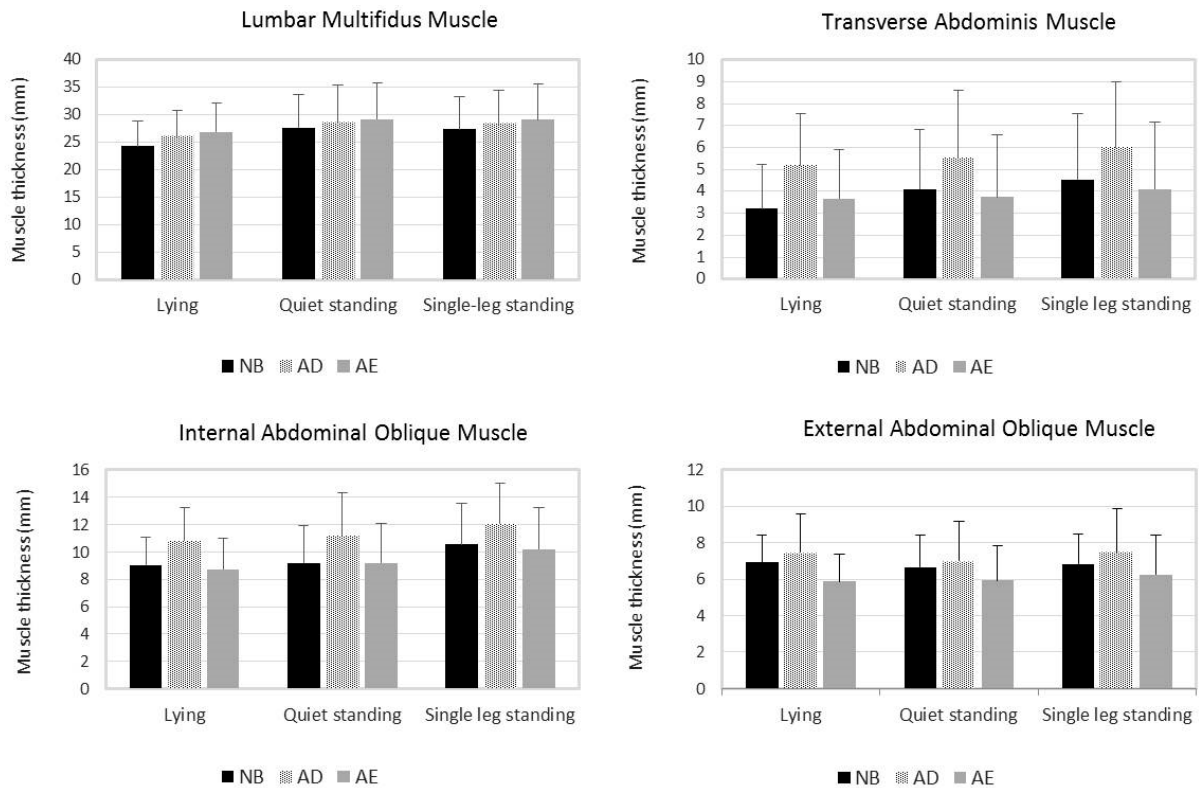
Figure 3. Mean thickness of the lumbar stabilization muscles during natural breathing (NB), abdominal drawing-in (AD), and abdominal expansion (AE) strategies in different body positions. Error bars indicate standard deviations.